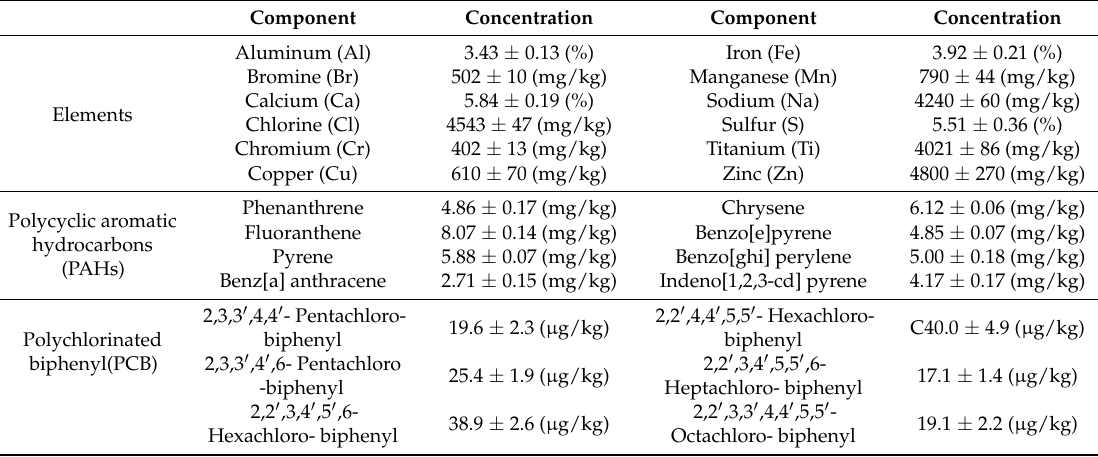
Table 1. Composition of